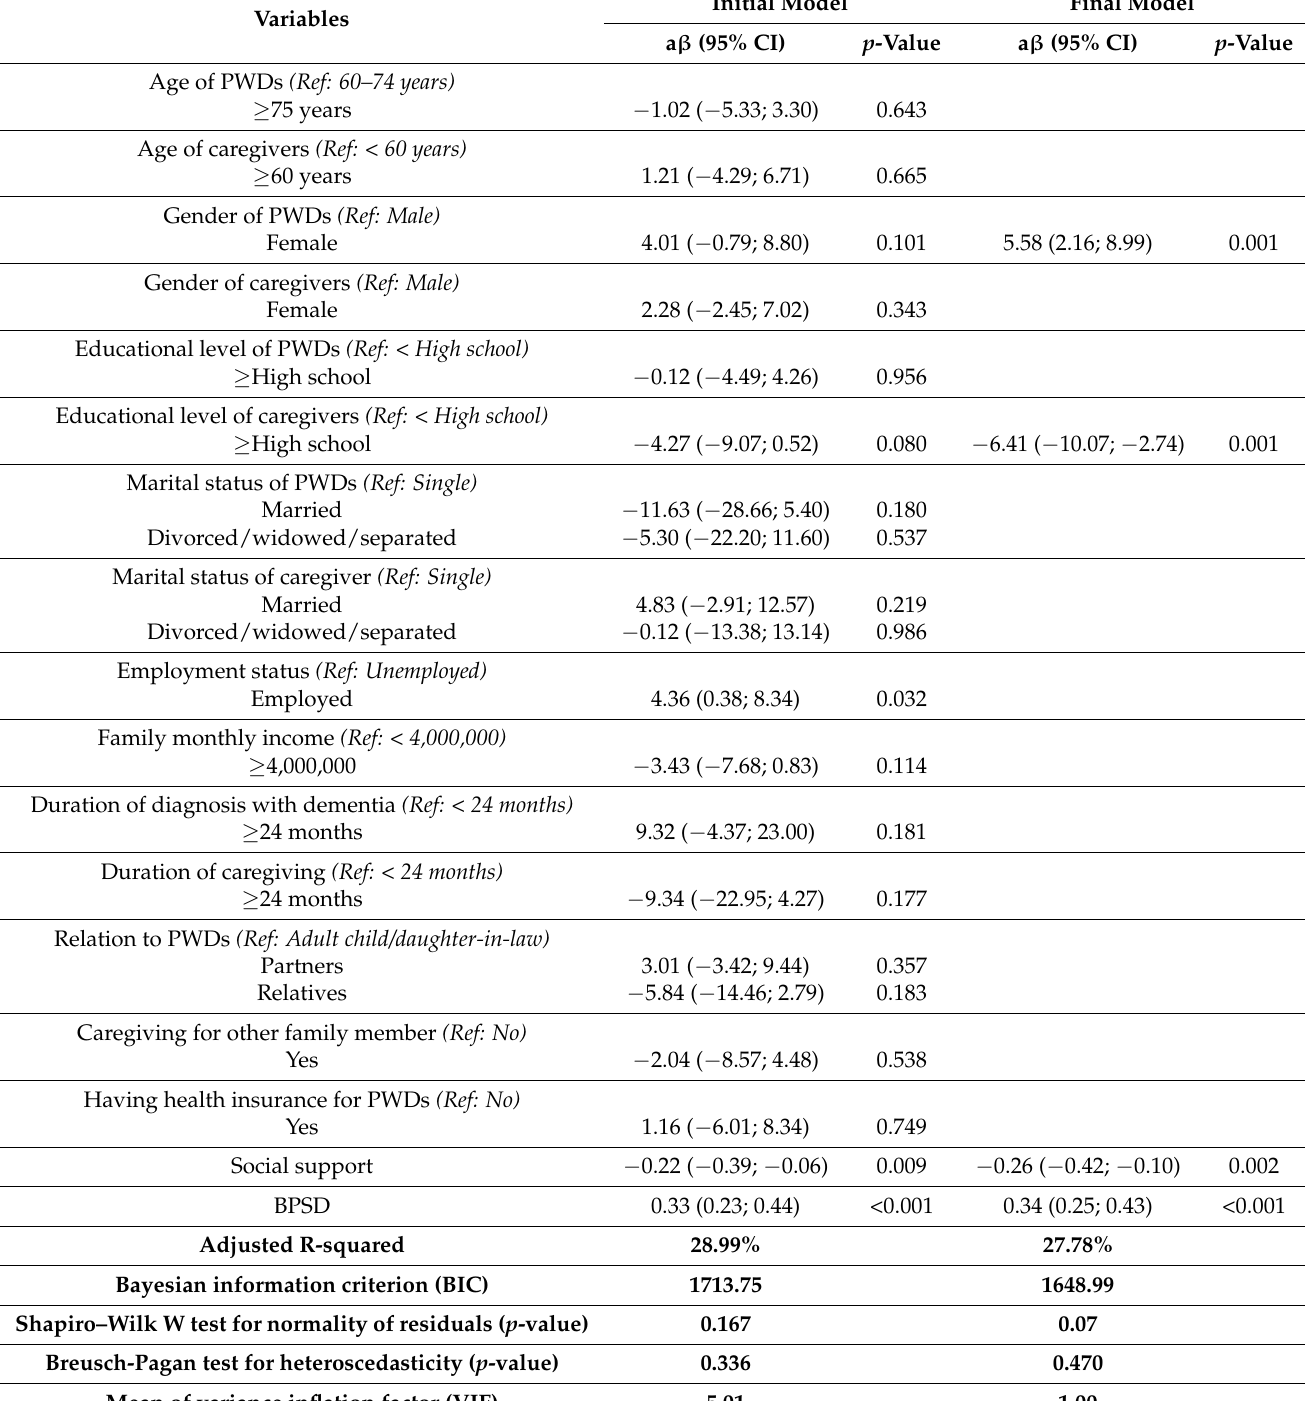
Table 4. Multivariate analysis of factors associated with caregiver burden ( n =